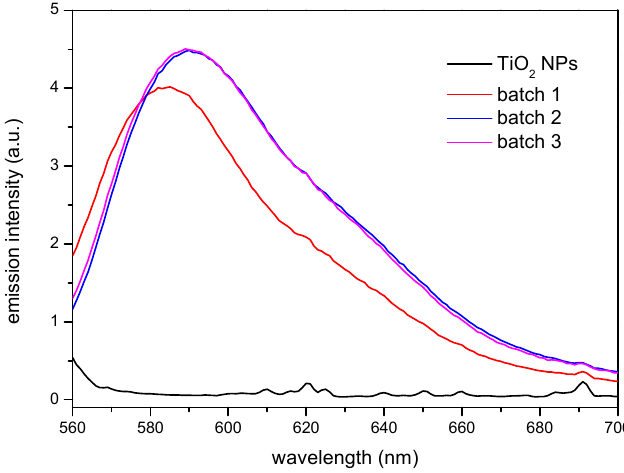
Figure 4. Solid phase fluorescence spectra of the as-received TiO 2 NPs and β CDTiO 2 NPs (batches 1, 2, and 3) after equilibration with a 4 × 10 − 6 M RhB solution.